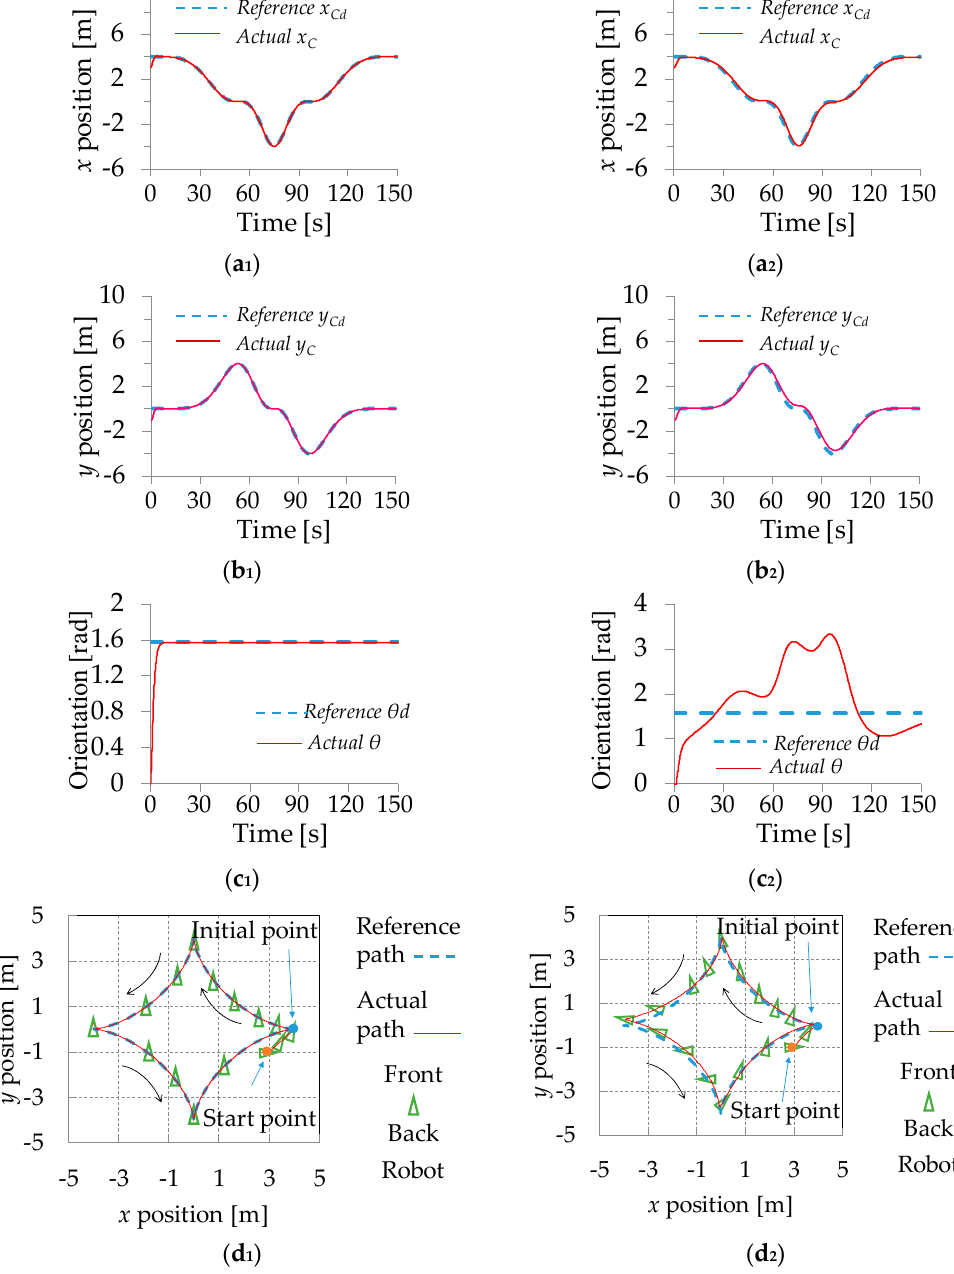
Figure 10. Trajectory and path tracking performance of non ‐ robust feedback tracking controller for the astroid path (primitive parameters m = 6 kg, r 0 = 0.2 m, α = π /2, R a = 0.56 Ω , and F friction = 0 : ( a 1 ) x position; ( b 1 ) y position; ( c 1 ) orientation θ ; and ( d 1 ) path tracking) (changed parameters m = 26 kg, r 0 = 0.3 m, α = π /3, R a = 0.76 Ω , and F friction = [0.2 N, 0.2 N, 0,3 N ∙ m]: ( a 2 ) x position; ( b 2 ) y position; ( c 2 ) orientation θ ; and ( d 2 ) path tracking).